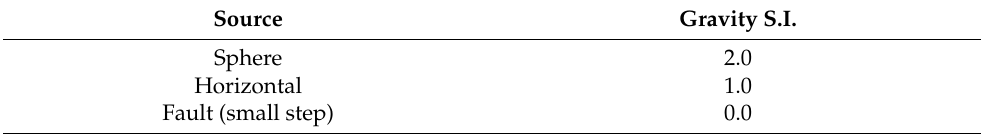
Table 1. Structural index for